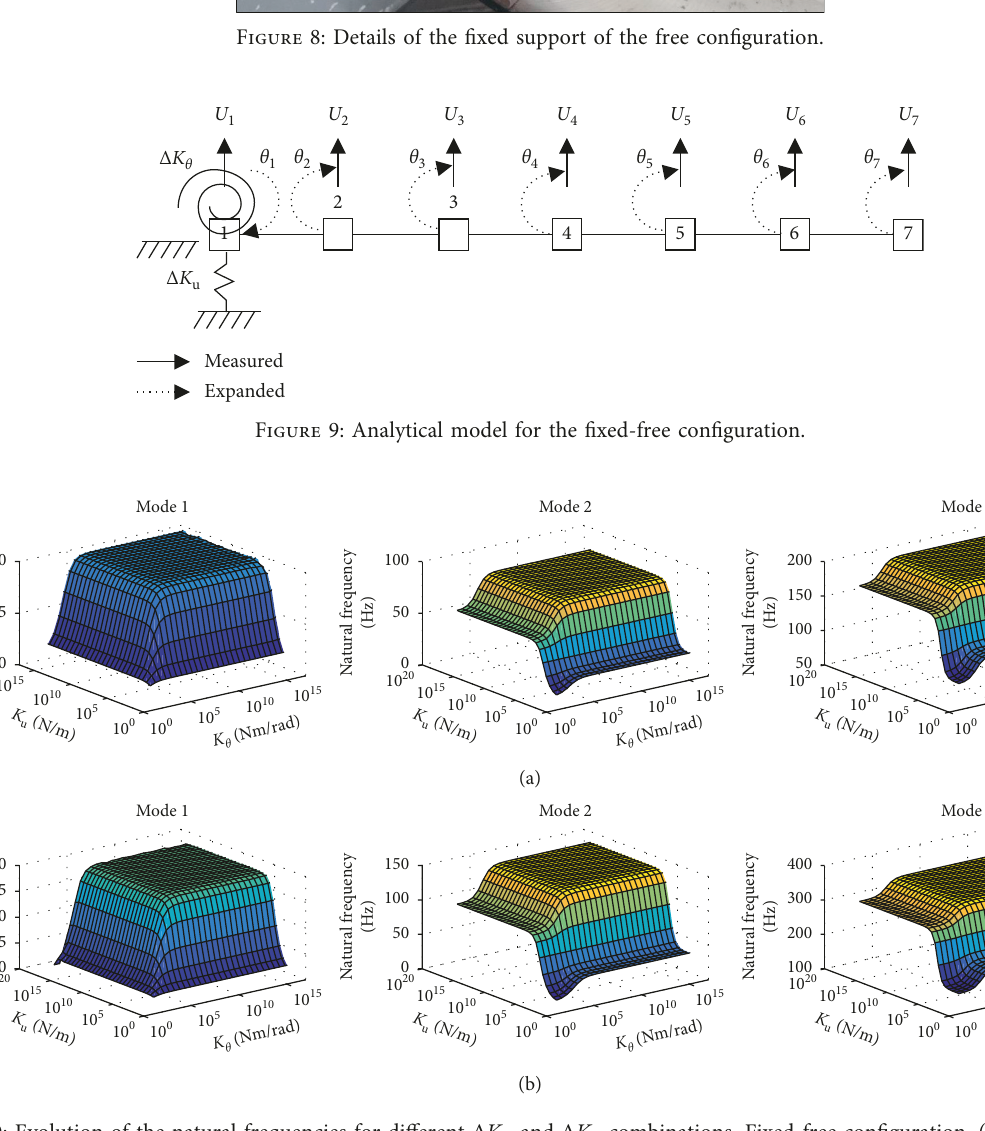
K combinations. Fixed-free configuration. (a) Weak Axis ( Y ). u and Δ θ